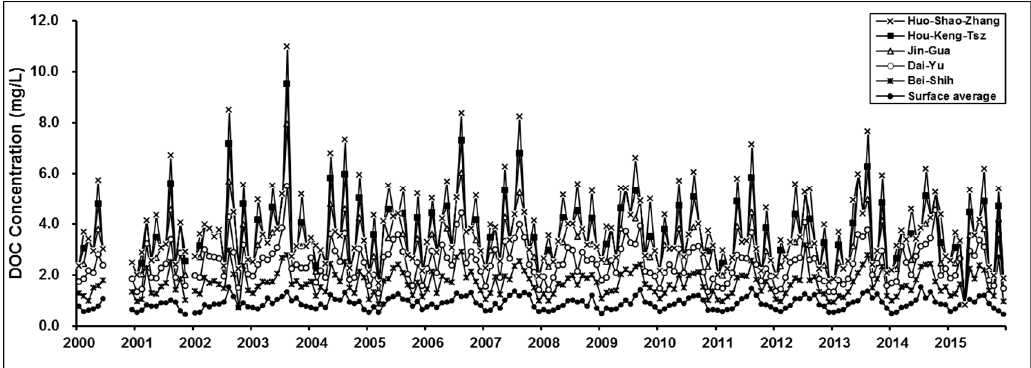
Figure 4. Time series of DOC concentrations in the water surface and tributaries of Fei-Tsui Reservoir from 2000 to 2015.